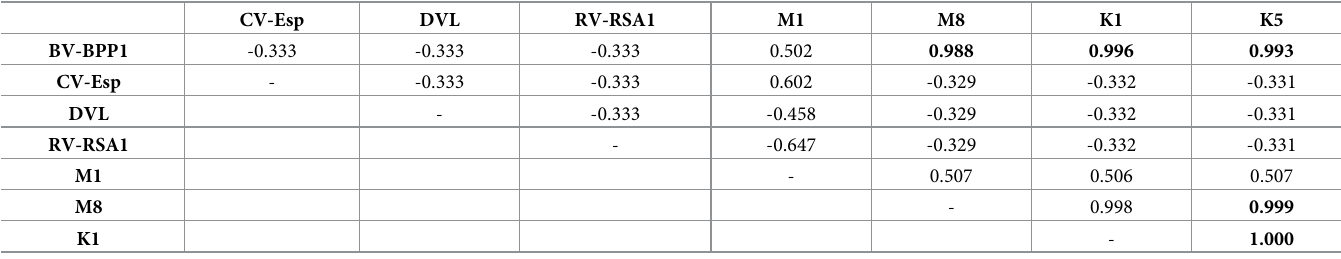
Table 4. Pearson’s correlation matrix of different phage species in positive samples.